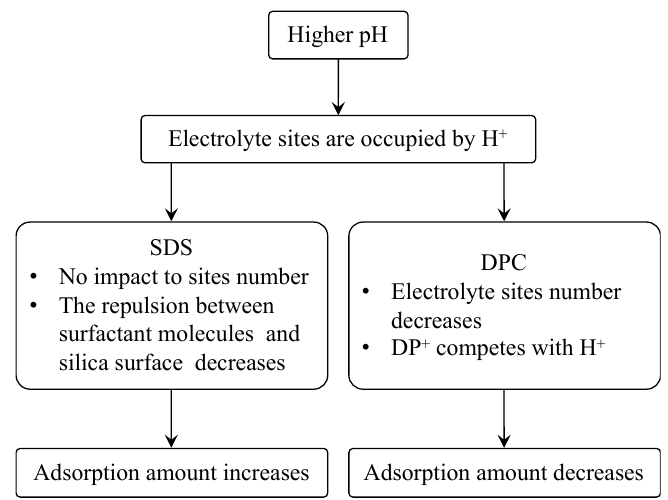
Figure 13. Comparison of adsorption mechanism and pH impact between SDS and DPC.